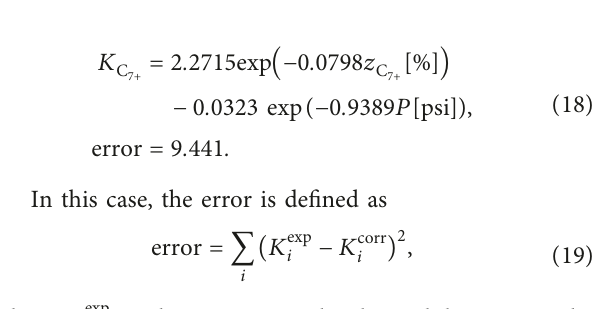
Figure 2: Degree of correlation of equilibrium constants with the system variables.